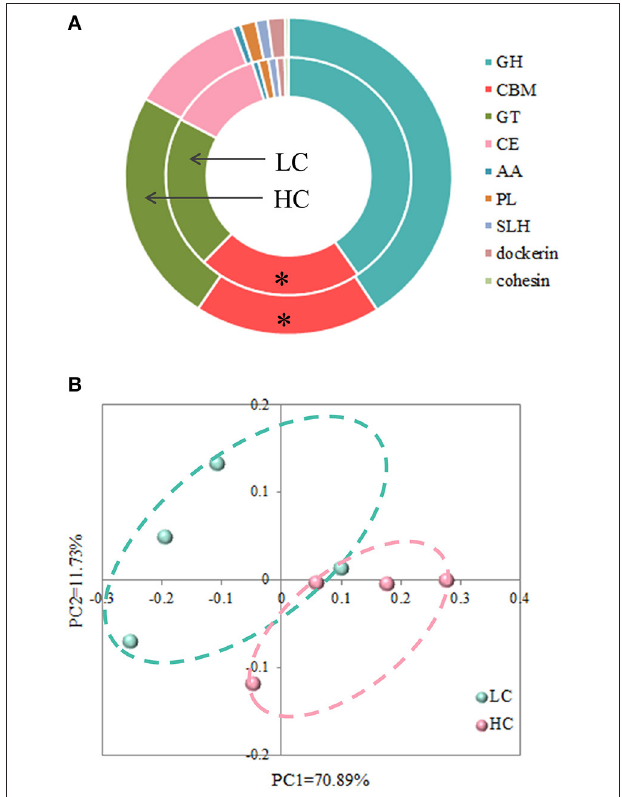
FIGURE 3 | Effects of high-concentrate (HC) diets on profiles of carbohydrate-active enzymes at the class (A) and phylum (B) levels. * p < 0.05.